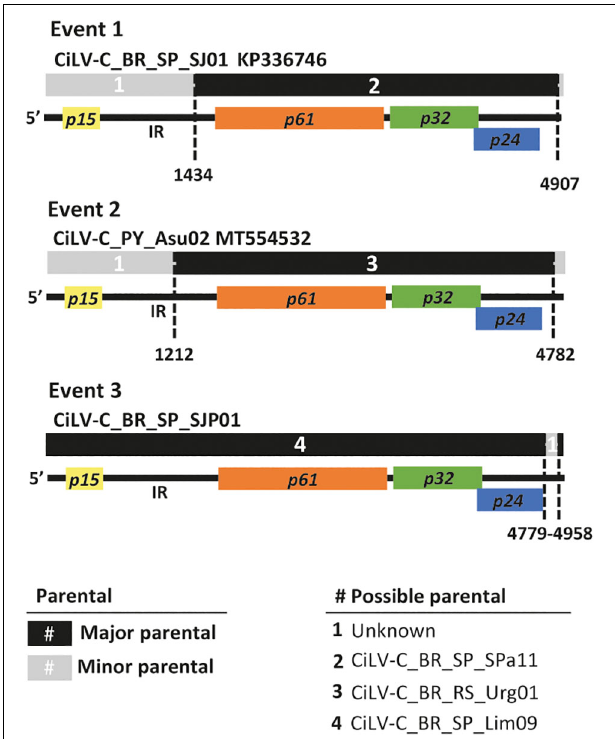
FIGURE 3 | Evidence of recombination in the RNA2 of CiLV-C. The diagram depicts three recombination events detected using the alignment of the completed RNA2 molecules of 23 isolates. Multicolored horizontal bars represent the genome of the recombinant molecules. Major and minor parentals are indicated by black and gray bars and numbers (#) as described in the legend. Dashed vertical lines indicate the recombination breakpoints using a cartoon representing the RNA2 molecule of CiLV-C as reference. Event 1 shows the recombination found in all isolates of the clade SJP, event 2 was detected in the isolate PY_Asu02 (clade ASU), and event 3 in BR_SP_SJP01 (clade SJP). Recombination events were detected by more than four programs implemented in the software RDP. Details of these and other recombination events are shown in Supplementary Table 4 .